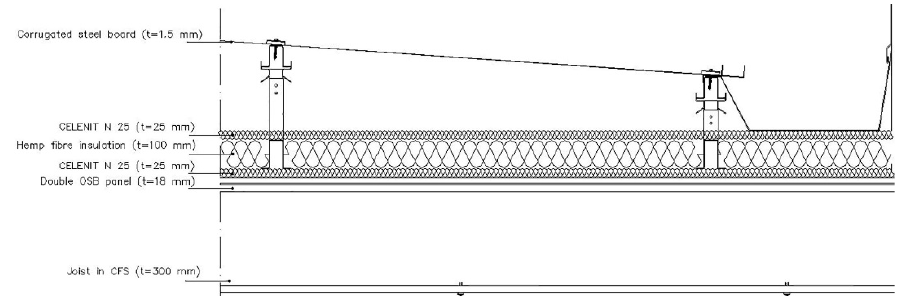
collection. Figure 5 includes all details.